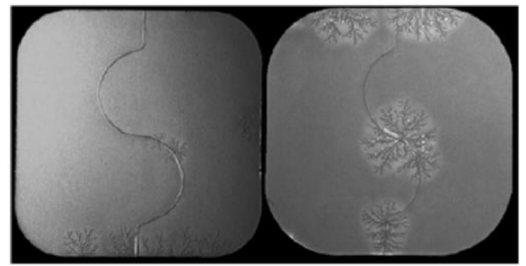
Figure 12. The appearance of the stable crystalline form of Rotigotine on the patches used for administering the drug. Reprinted with permission from Ref. [43]. 2015, Elsevier.